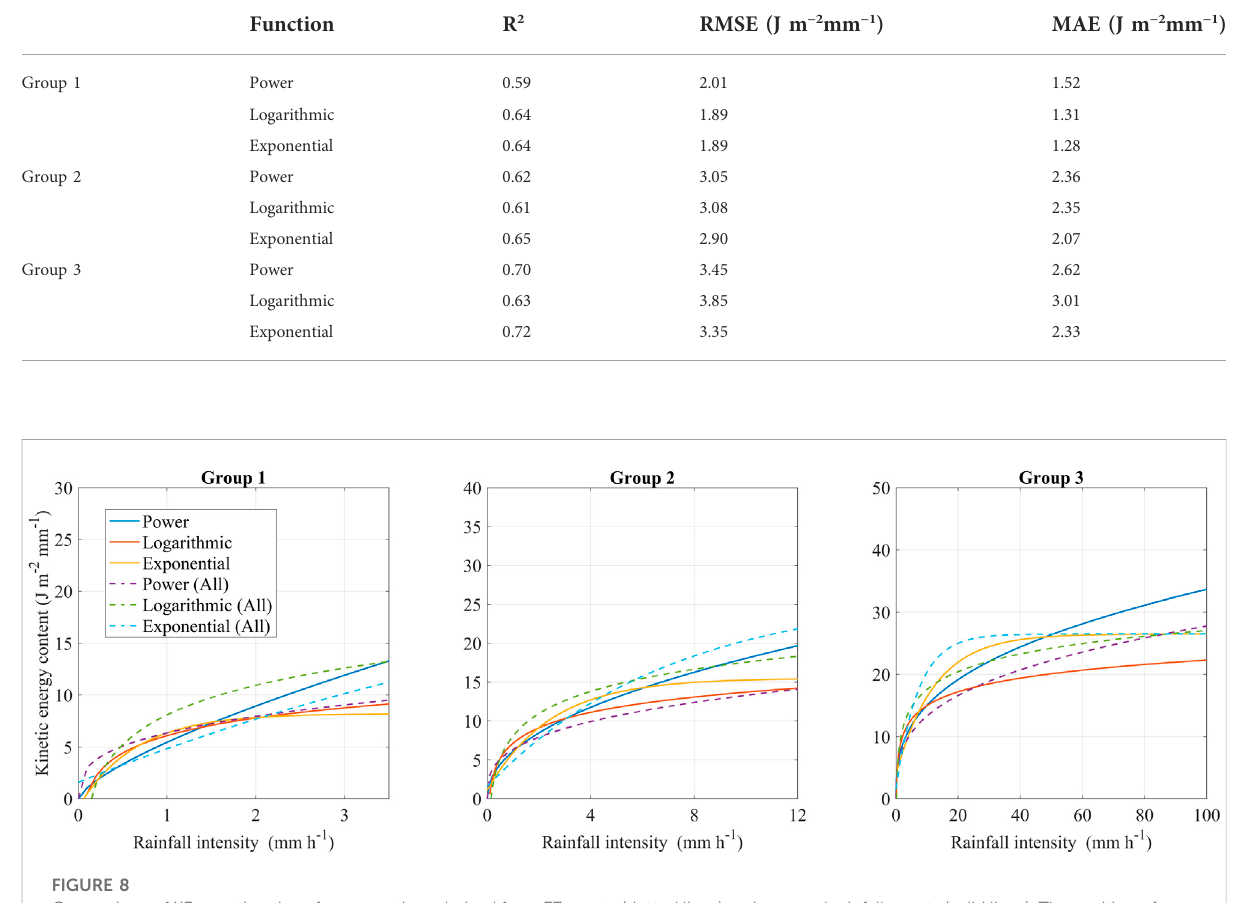
TABLE 6 Statistical analysis of the relationship between KE con and I r corresponding to the three rainfall event groups.